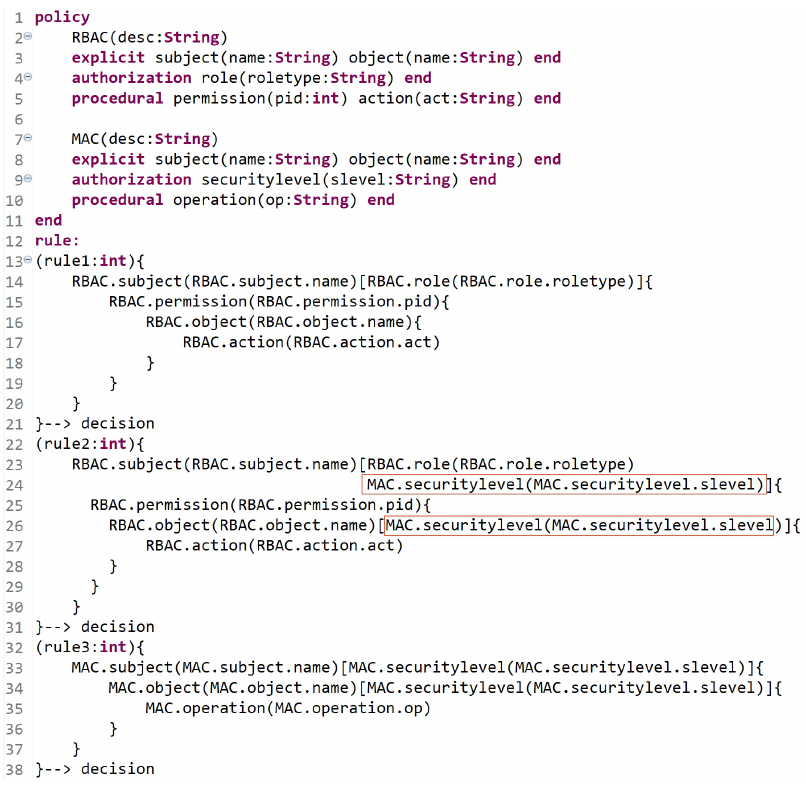
Figure 18. Dynamic AC metamodel: Scenario